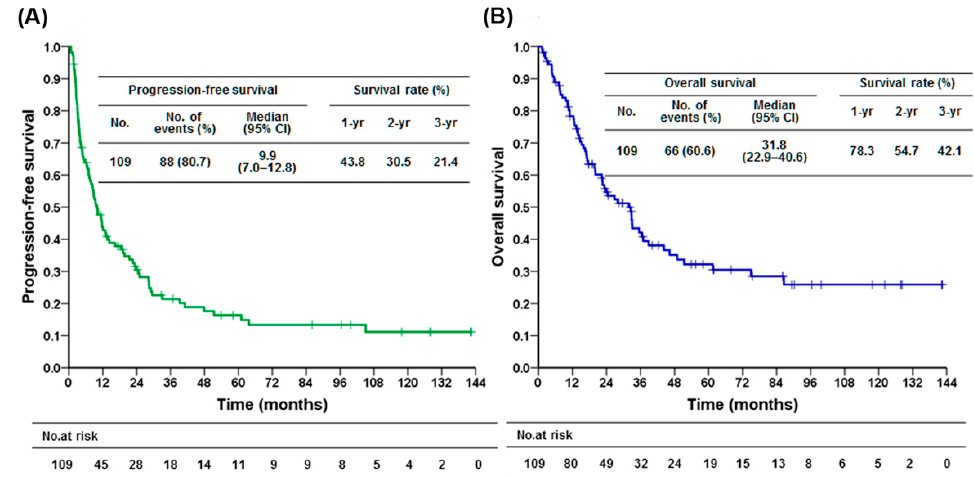
Figure 1. Survival after sunitinb use in patients with GIST. ( A ) Kaplan–Meier plot of the progression-free survival (PFS) for 109 patients with advanced gastrointestinal stromal tumor (GIST) treated with sunitinib. ( B ) Kaplan-Meier plot of the overall survival (OS) for 109 patients with advanced gastrointestinal stromal tumor (GIST) treated with sunitinib.